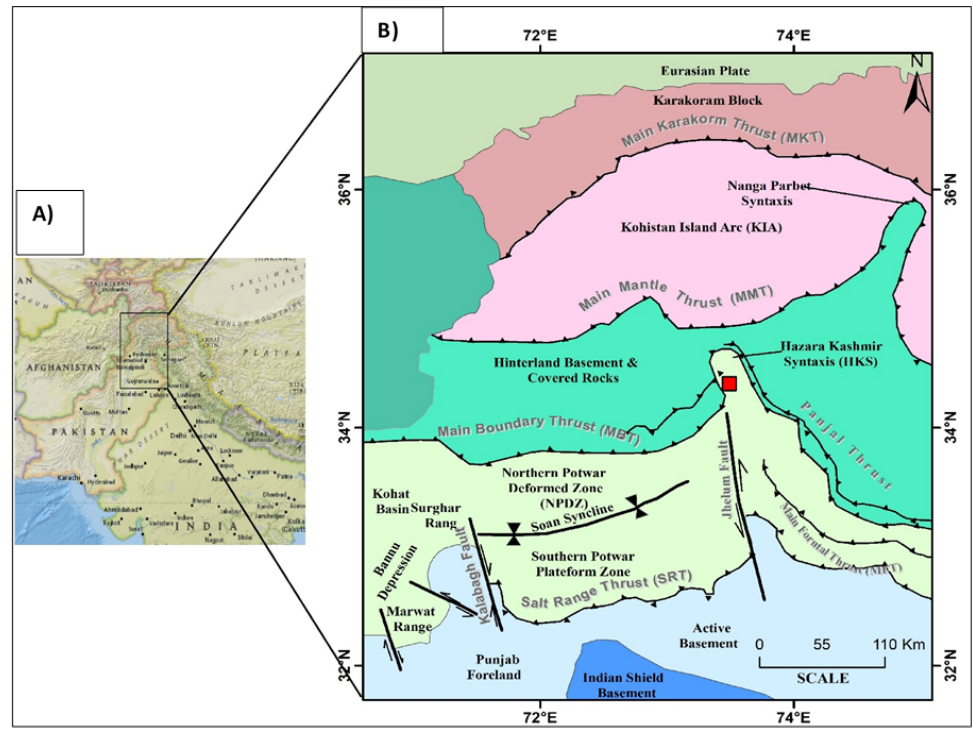
Figure 1. ( A ) Regional location map of the northern Pakistan; ( B ) tectonic map of northern Pakistan. Red square showing the study area (compiled and adopted after [4–6] ).